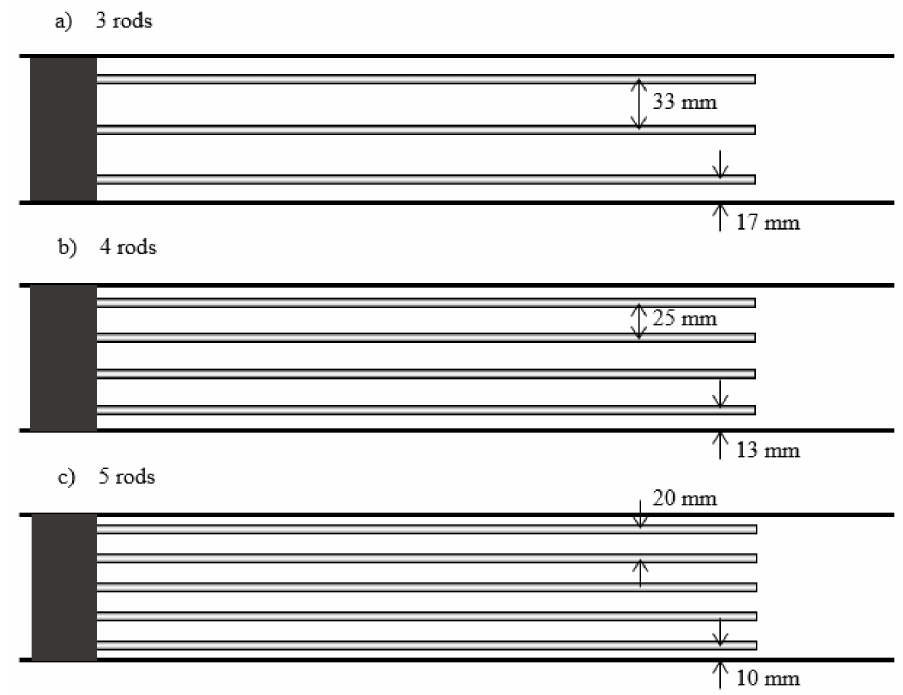
Figure 6. Schematic view showing the rod spacing for traps with ( a ) three, ( b ) four, and ( c ) five rods.